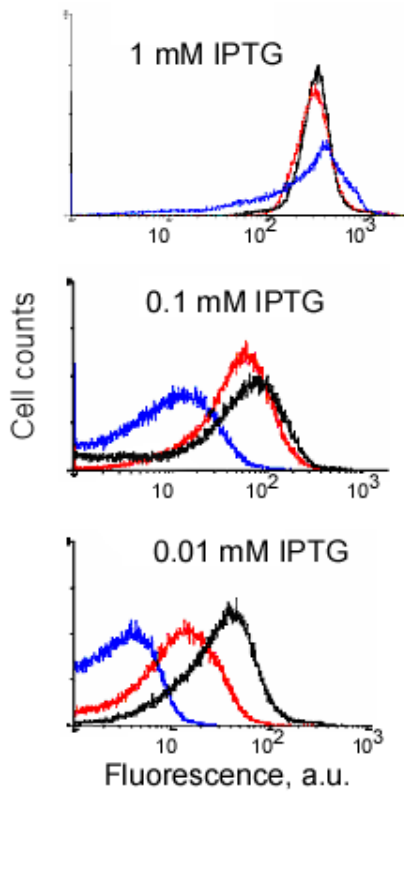
Figure 4. Low concentration of IPTG allows discrimination of signal from the background using binary aptamer/peptide interactions. Blue, fluorescence distributions of the cells expressing two fusion proteins in RNA absence; red, fluorescence distribution of the cells expressing two fusion proteins and RNA aptamers with the wrong sequences (two HTLV-1 Rex aptamers); black, fluorescence distribution of the E. coli cells expressing two fusion proteins and RNA with two cognate